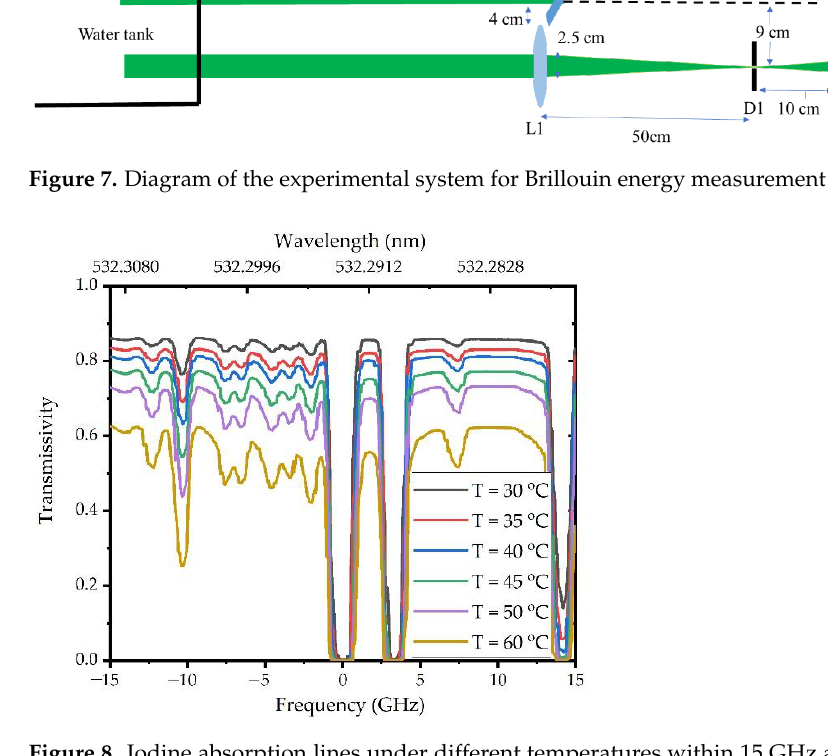
Figure 8. Iodine absorption lines under different temperatures within 15 GHz at a wavelength of approximately 532.293 nm.